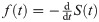
Survival function, probability density function and bacterial release on rupture.Left: the macrophage survival probability function, S(t). Centre: the bacterial load is proportional to f(t)=-ddtS(t). The vertical line is (6). Right: the function n¯(t) that gives the mean number of bacteria released per macrophage. The parameter values, taken from Ref. [23], are β = 0.15 h−1, μ = 0.01 h−1 and δ = 0.001 h−1. The dashed lines show the corresponding functions when μ = 0.